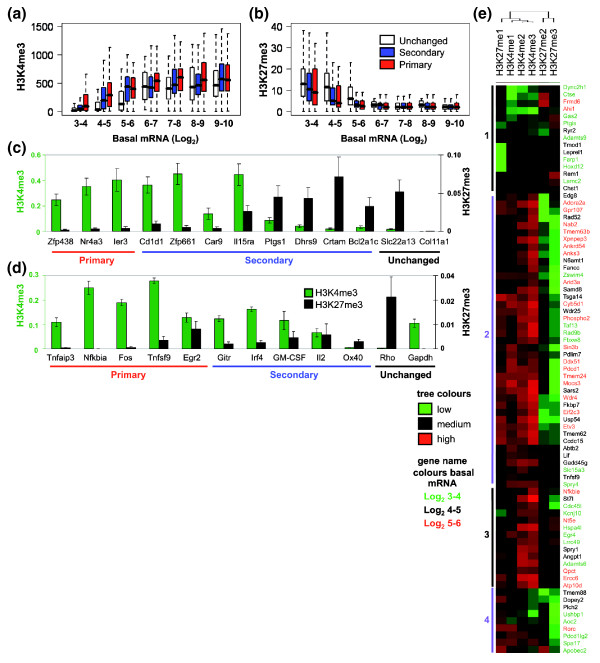
Inducible genes have higher levels of H3K4me3 and lower levels of H3K27me3. (a, b) Data from ChIP-Seq experiments with human CD4+ lymphocytes [28] were analyzed to determine the levels of H3K4me3 (a) and H3K27me3 (b) on different gene groups. The number of sequencing tags that overlapped with the promoter region (-1 kb to +1 kb) of each gene was used to score the genes and the data are plotted for the genes grouped by their kinetics of response to activation (red, primary response genes; blue, secondary response genes; white, unchanged genes) and basal expression levels (Log2 robust multichip average values from expression profiling). The bar marks the median score, the edges of the boxes the second and third interquartile ranges and the whiskers the first and fourth interquartile ranges. (c, d) ChIP was performed with antibodies against H3K4me3 (green bars) and H3K27me3 (black bars) using unstimulated EL-4 T cells and analyzed by real-time PCR, with primers designed against the promoter region. The data are presented as a ratio of immunoprecipitated DNA to total input DNA. The mean and standard error of three independent experiments are shown. (e) From the same data source used in (a) the number of sequencing tags for mono, di and tri-methylated H3K4 and H3K27, overlapping -1 to +1 kb from the TSS, were counted for primary response genes with basal expression values between Log2 3 and 6. The logs of the sequence counts were median centered and normalized and heatmaps for the primary response genes were generated by uncentered correlation, complete linkage clustering. The major clusters are marked and the genes are colored according to their basal expression level (green, log2 3 to 4; black, log2 4 to 5; red, log2 5 to 6). In the cluster diagram green indicates low tag counts and red indicates high tag counts.